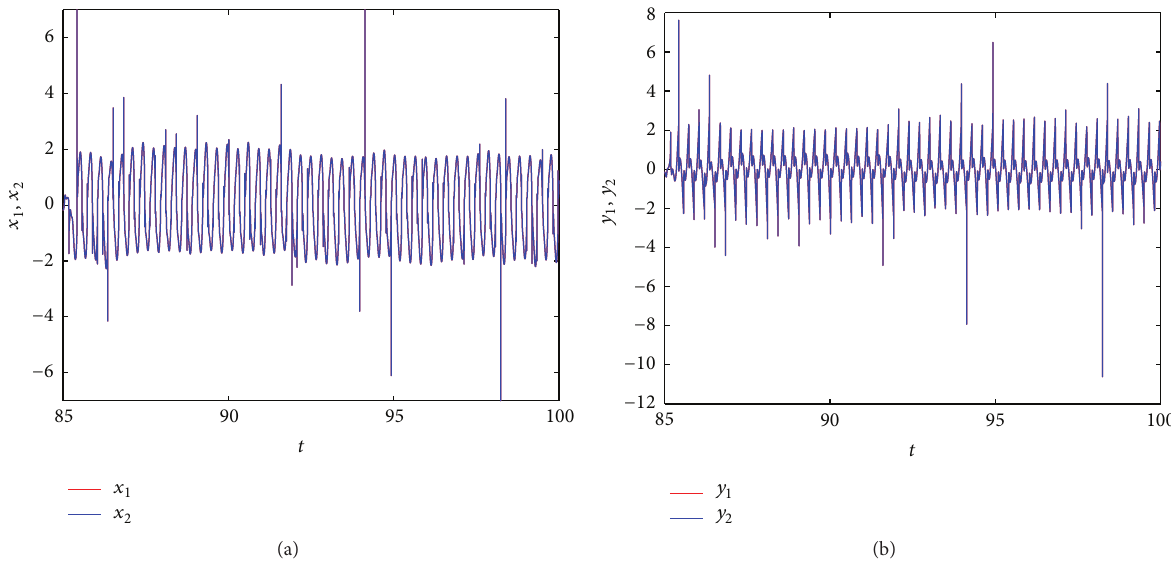
Figure 3: When 𝜏 ∈ [𝜏 + 0 𝜏 − 1 ] , the zero equilibrium is unstable. 𝑇 = 0.01 and initial conditions: 0.0008 ⋅ (1, 1,1, 1, 1, 1,1, 1) , 𝜏 = 0.029 .